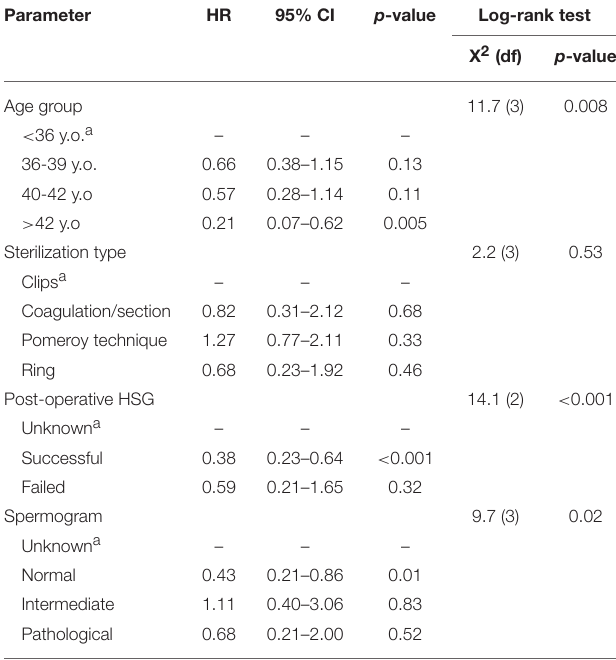
TABLE 2 | Univariate Cox proportional hazards analysis for time to pregnancy including hazard ratio (HR), 95% confidence interval (95% CI) and significance (p-value), as well as the results of the associated log-rank